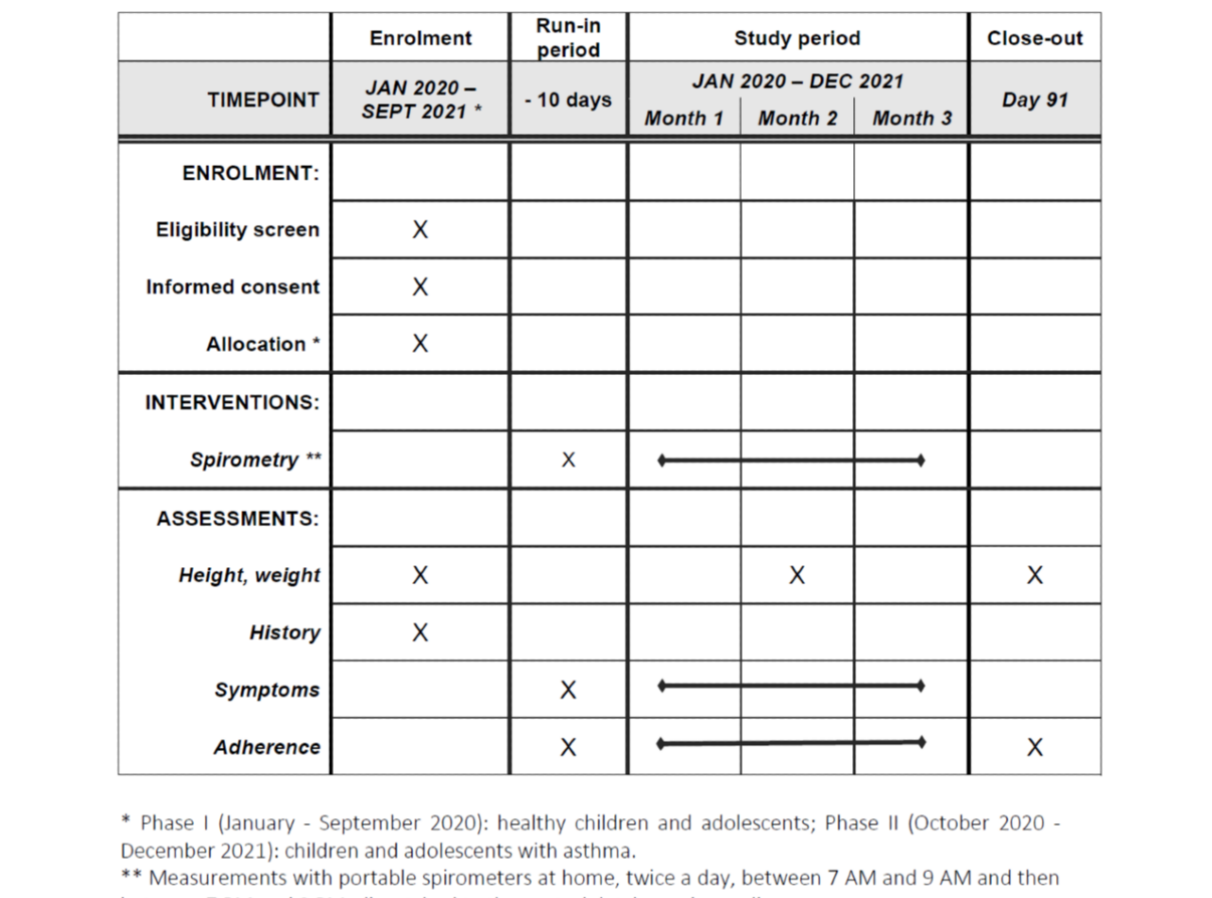
Figure 2. Standard protocol items: recommendations for interventional trials (SPIRIT) checklist.